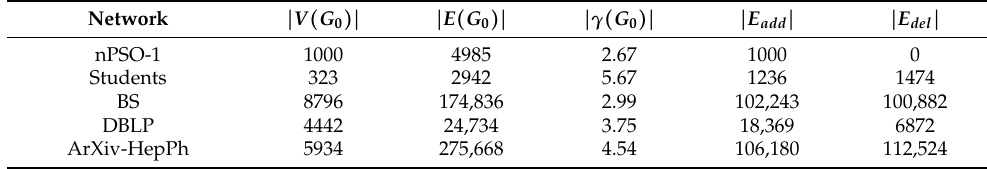
Table 4. The statistical metrics of the datasets.